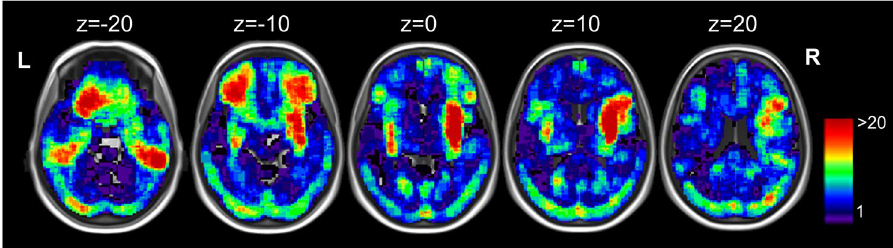
Figure 1. Lesion overlap of all patients ( n = 153) presented on axial slices from caudal (z = − 20) to cranial (z = 20) from a standard MRI template. Scale bars represent t-scores. L: left hemisphere, R: right hemisphere. Note that z-coordinates relate to MNI